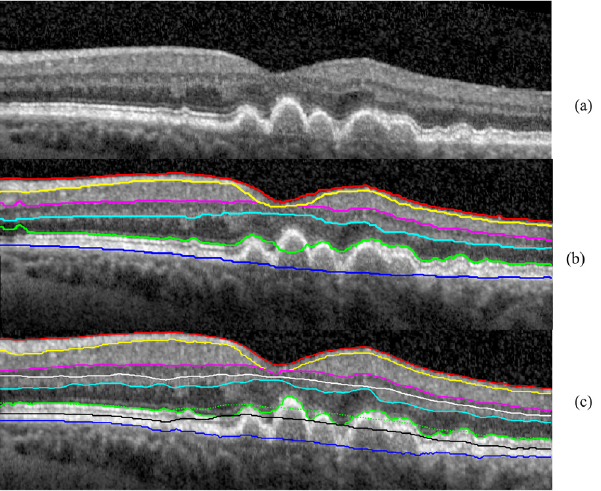
significantly lower than the inter-observer difference ( p < 0.001) for all of the eight bound- aries. The upper bound of detection errors was between 1.86 to 4.36 pixels. (cid:129) Results of OCTRIMA 3D for segmenting retinal images showing pathological features The segmentation results of OCTRIMA 3D are shown in Fig 11 and Fig 12. As it is shown in